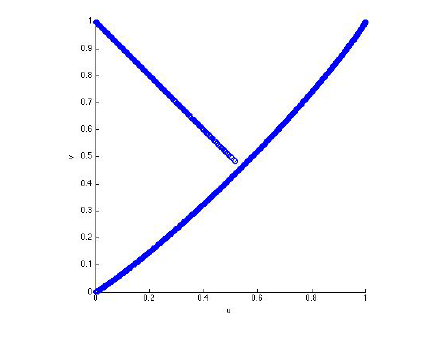
η 2 at time t = 1 with η = t